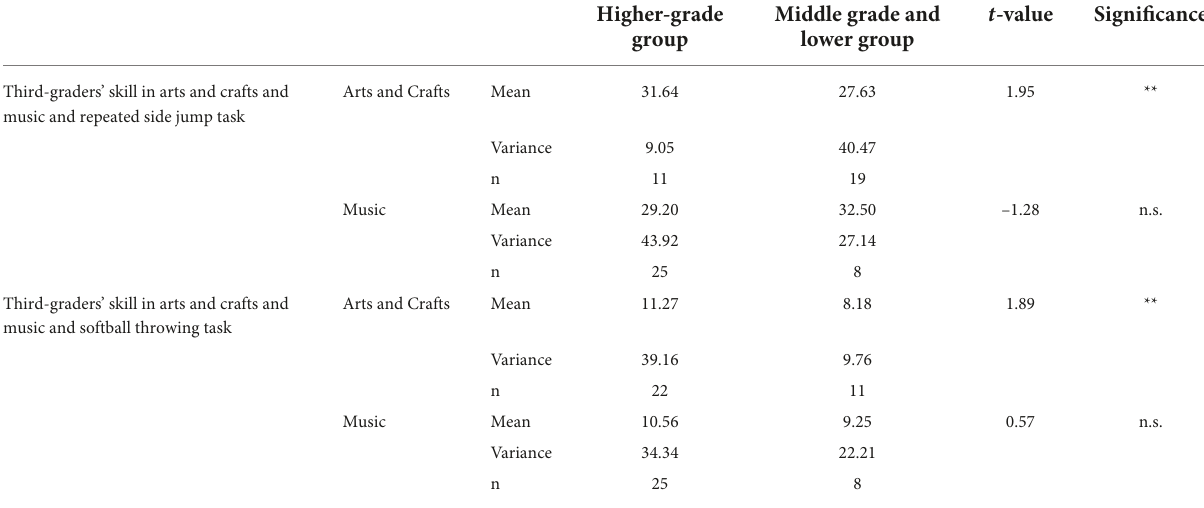
TABLE 3 Third-grade students’ skill in arts and crafts and music and the repeated side jump task, softball throwing task (September–December 2011).